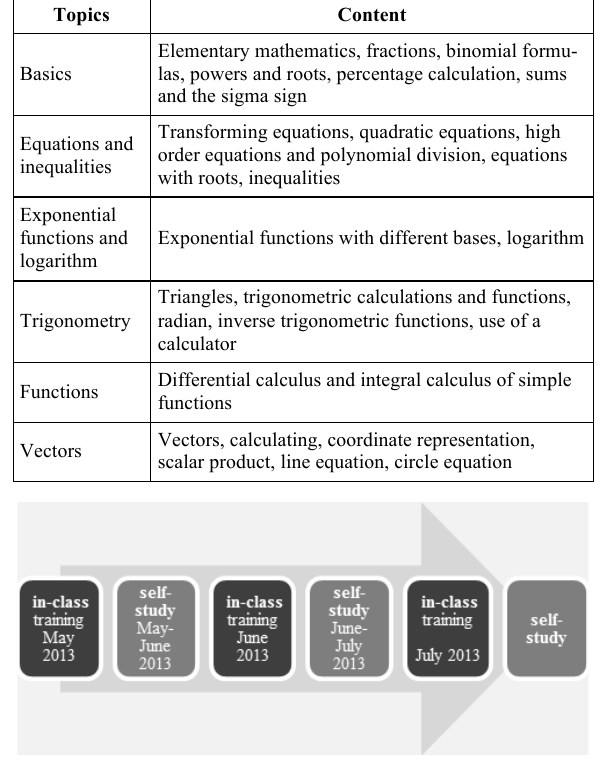
TOPICS AND CONTENTS OF THE PREPARATORY MATH Topics